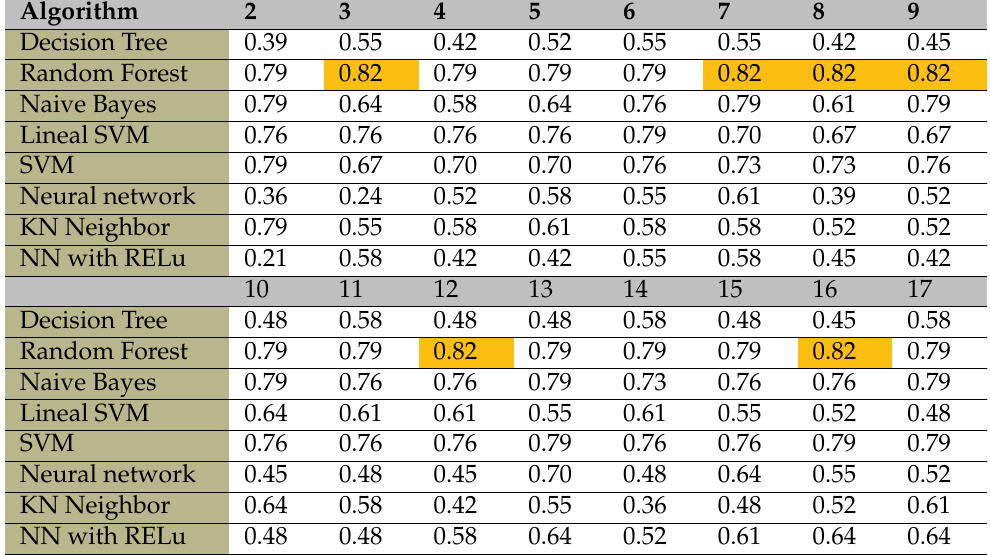
Table 4. Table of accuracy with mutual_info_classif without height and weight.